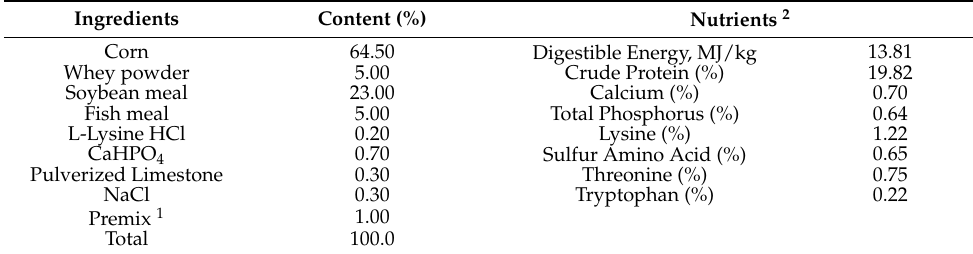
Table 1. Ingredients and nutrient levels of basal diet (air dry basis)%.